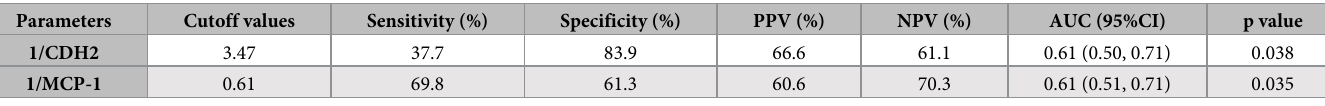
Table 7. Diagnostic performance of 1/CDH2 mRNA and 1/MCP-1 mRNA for incipient DN detection. Parameters Cutoff